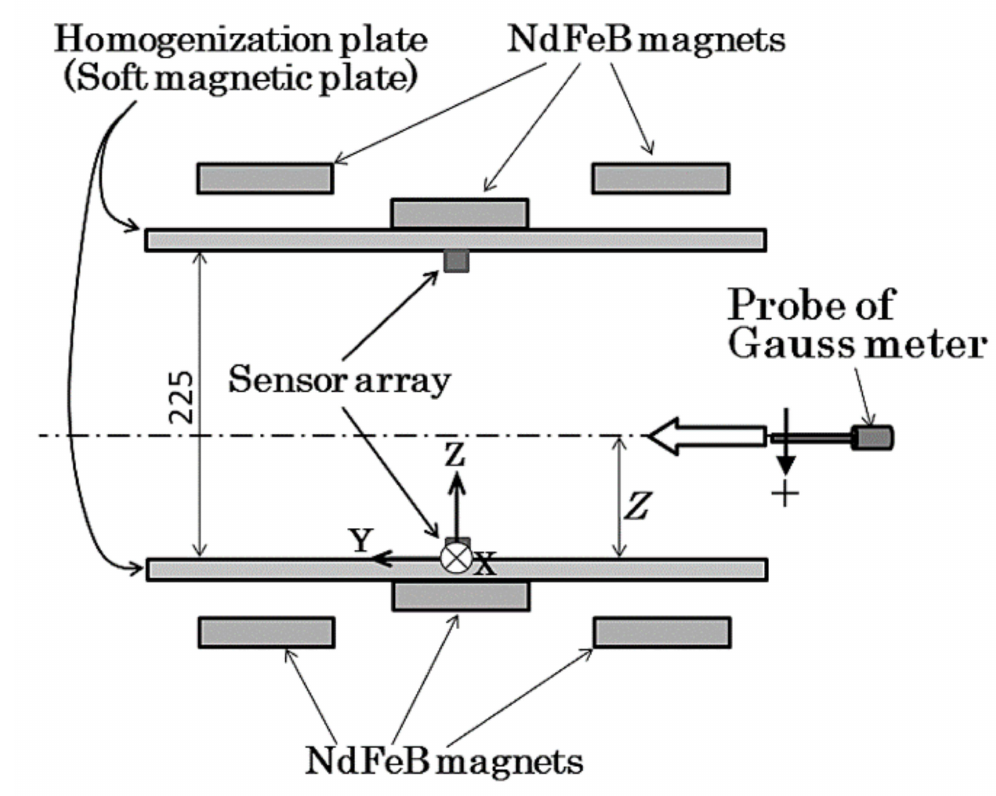
Figure 7. Schematic of the measurement procedure of the magnetic field profile. (Unit: